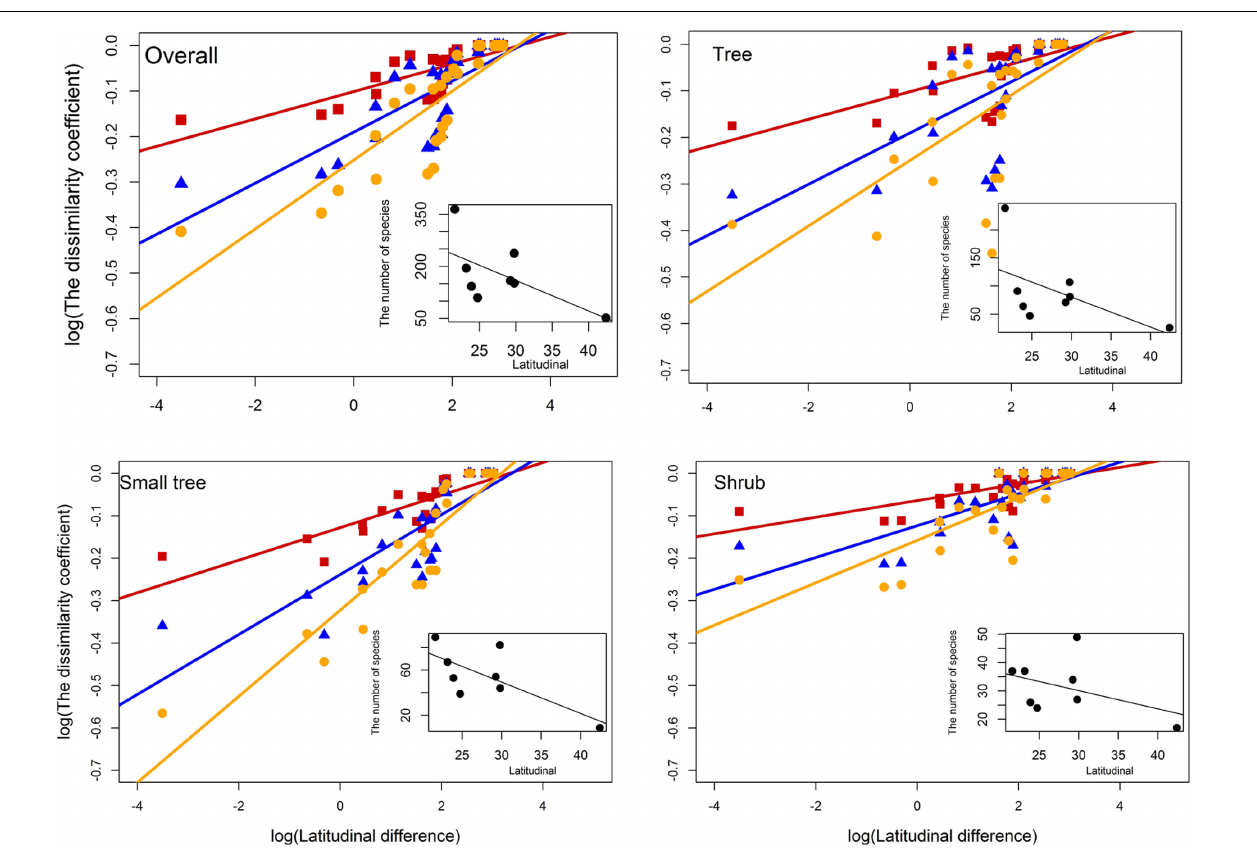
FIGURE 4 | Patterns of overall species turnover ( β j : R = 0.5895 ∗∗∗ ; β s : R = 0.5824 ∗∗∗ ; β sim : R = 0.6929 ∗∗∗ ), trees ( β j : R = 0.4009 ∗∗∗ ; β s : R = 0.4011 ∗∗∗ ; ∗∗∗ ), small trees ( β ∗∗∗ ; β s : R = 0.6764 ∗∗∗ ; β ∗∗∗ ), and shrubs ( β ∗∗∗ ; β s : R = 0.5247 ∗∗∗ ; β β sim : R = 0.4144 j : R = 0.6859 sim : R = 0.8175 j : R = 0.5250 sim : R = 0.6021 ∗∗∗ ) in different forest dynamics plots along the latitude difference. Red square and line represent β j , blue triangle and line represent β s , and yellow dot and line represent β sim . The subset shows the relationship between the number of species and latitudinal across multiple forest dynamics plots. Latitude difference is the difference in latitude values between the